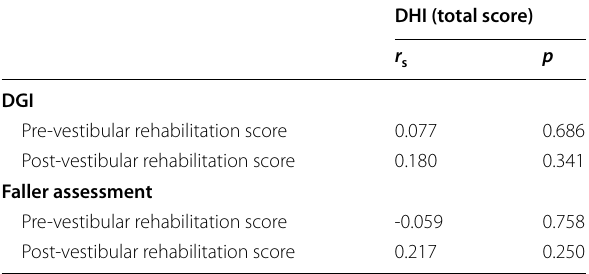
Table 17 Correlation between subjective (DHI) and objective (DGI and faller assessment) outcome measures